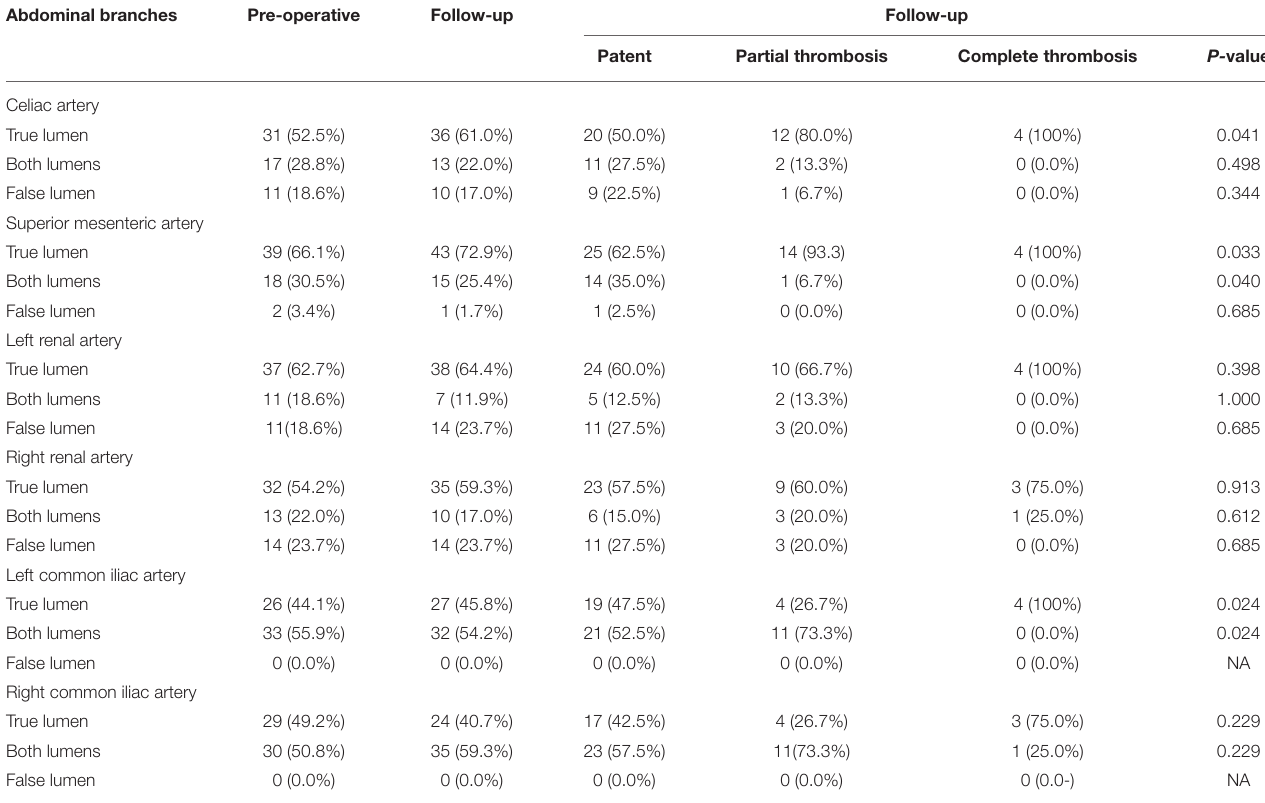
TABLE 6 | Abdominal branch perfusion patterns in the celiac artery, superior mesenteric artery (SMA), left renal artery (LRA), right renal artery (RRA), left common iliac artery, and right common iliac artery according to FL status. Abdominal